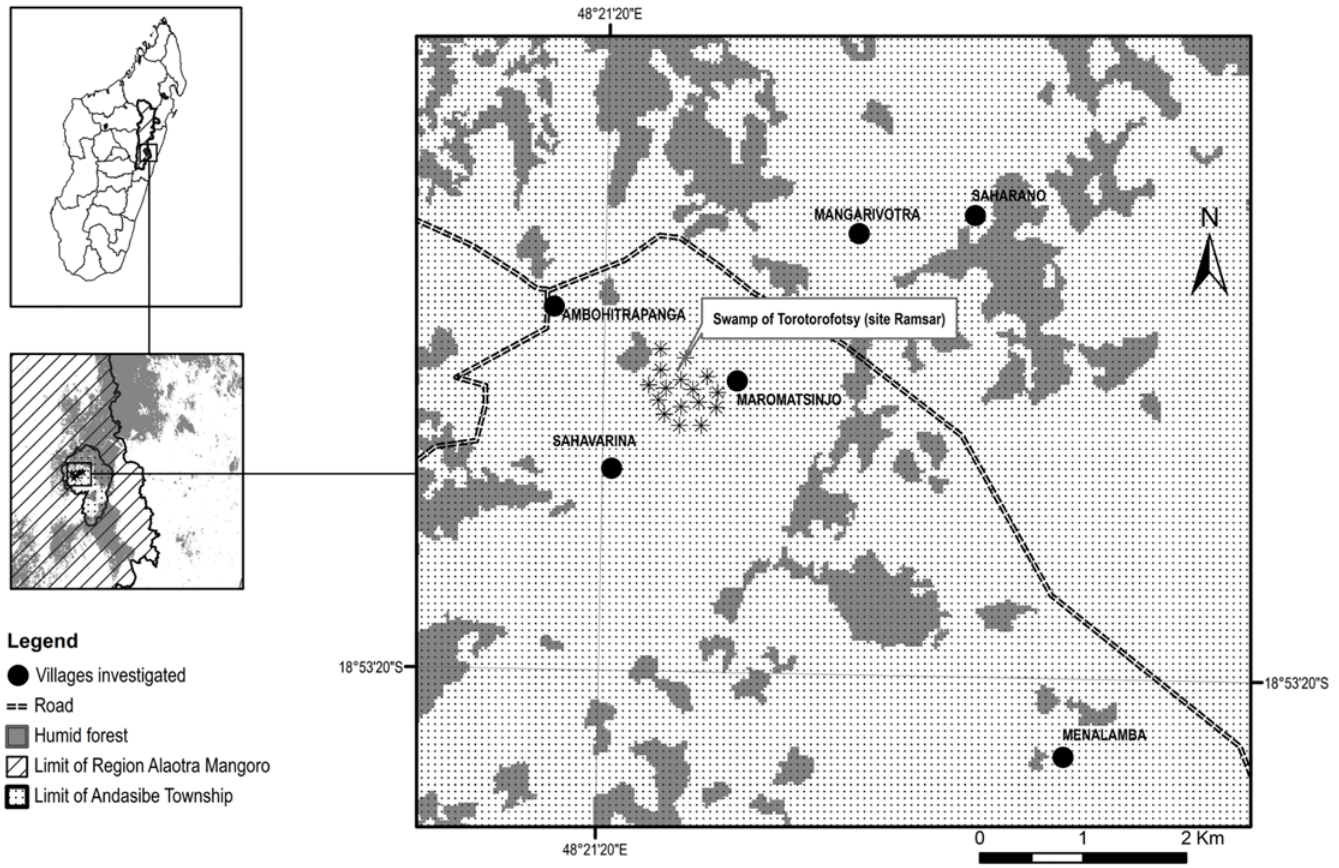
Fig 1. Map of Torotorofotsy Protected Area, our study site within east central Madagascar. Points denote 11 villages visited for interviews. Participants from two villages (Andasitsimanga and Menalamba Analakely) were interviewed in Menalamba village. Menalamba, denoted by a single point on the map, encompasses four smaller subvillages of a larger jurisdictional village that were visited on separate